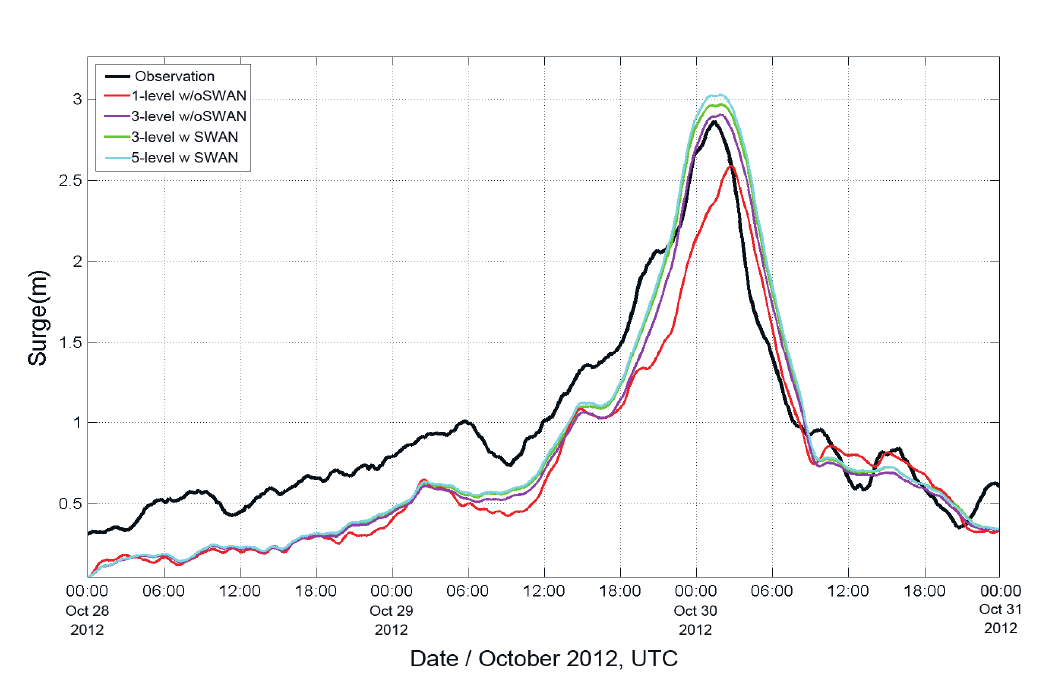
Figure 5. Simulations of surge using different configurations of 2D and 3D ADCIRC (3 and 5-vertical layers) and with or without SWAN in